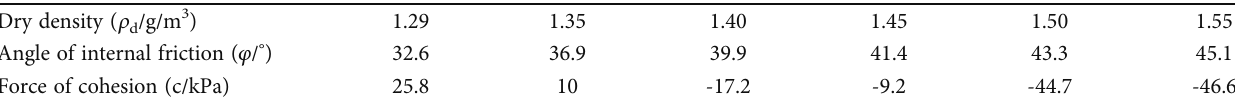
Table 2: Internal friction angle and cohesion at di ff erent dry